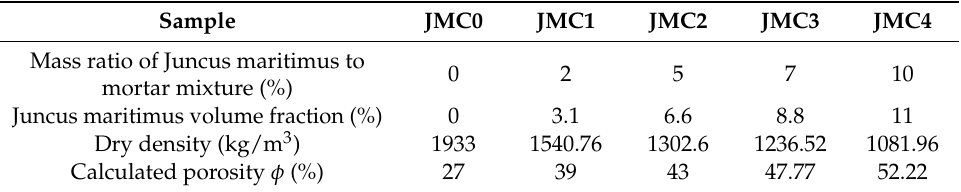
Table 3. Physical properties of composite samples; JMC0, JMC1, JMC2, JMC3, JMC4 are the Juncus maritimus/mortar samples corresponding to the Juncus maritimus mass fractions (0, 2%, 5%, 7%, and 10%), respectively.